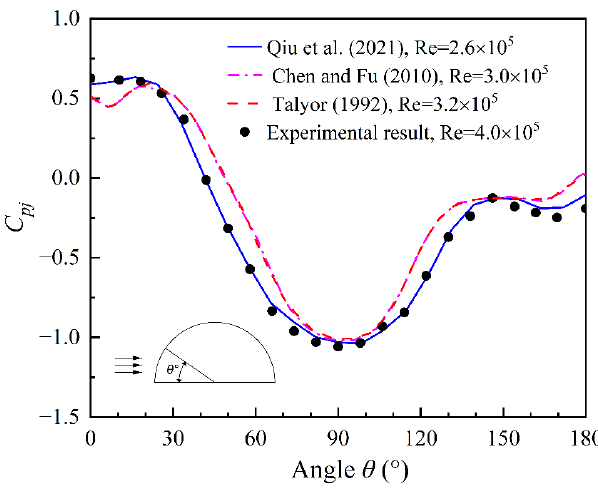
Figure 6. Comparison of the mean pressure coefficients along centerline of the model ( H / L = 0.50) Comparison of the mean pressure coefficients along centerline of the model [8,9,29]. ( H / L = 0.50)